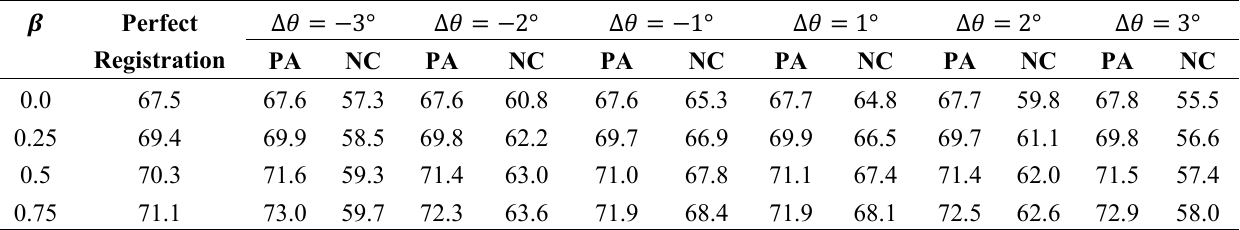
Table 14. Overall accuracies for different values of β in two extreme cases and our proposed algorithm for different rotation error Δθ where PA and NC denote the cases of the proposed algorithm and no registration error correction,